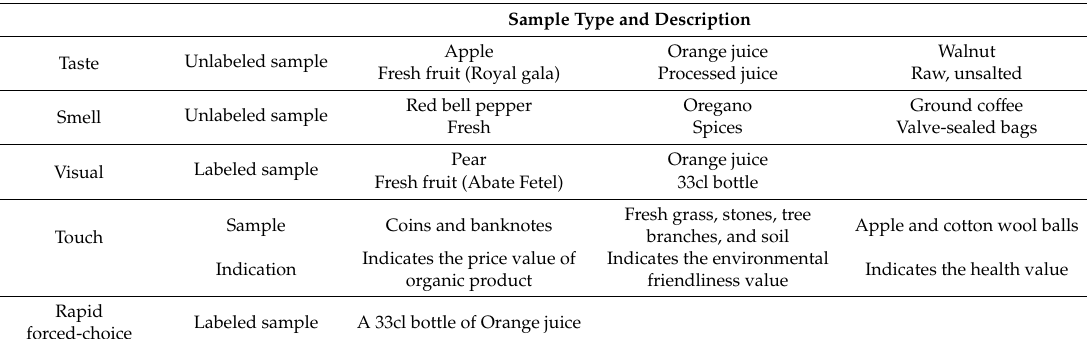
Table 1. Type and specification of the samples that were used in the emotional profiling. Sample Type and